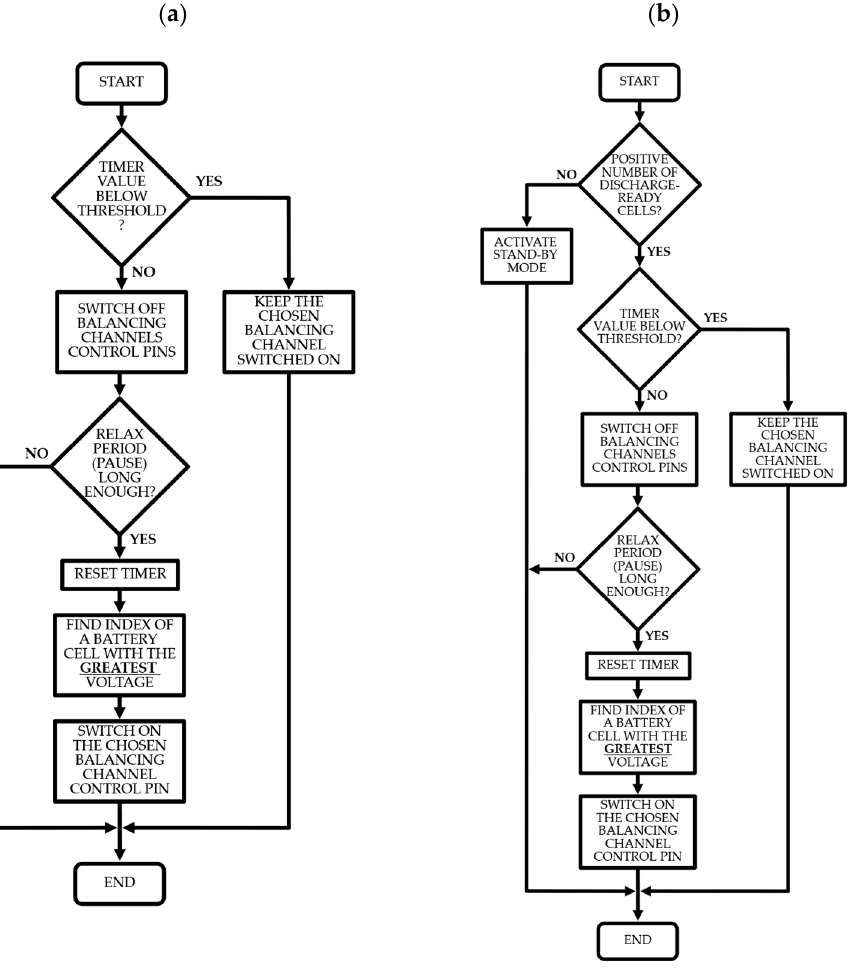
Figure 10. Balancing ( a ) and permanent storage mode ( b ) process flowchart.